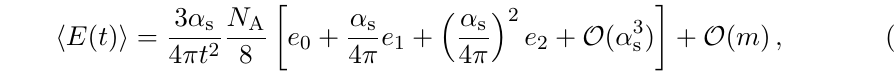
Table 1 . The number of Feynman diagrams contributing to the quantities computed in this section. At three-loop level, the number for \quenched QCD" (marked as T R = 0) is shown